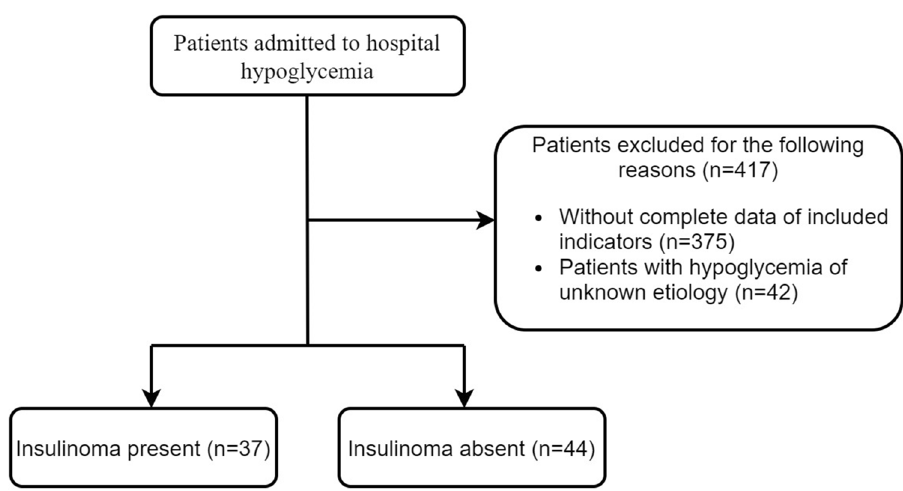
Fig. 1 Flowchart of the sam- ple